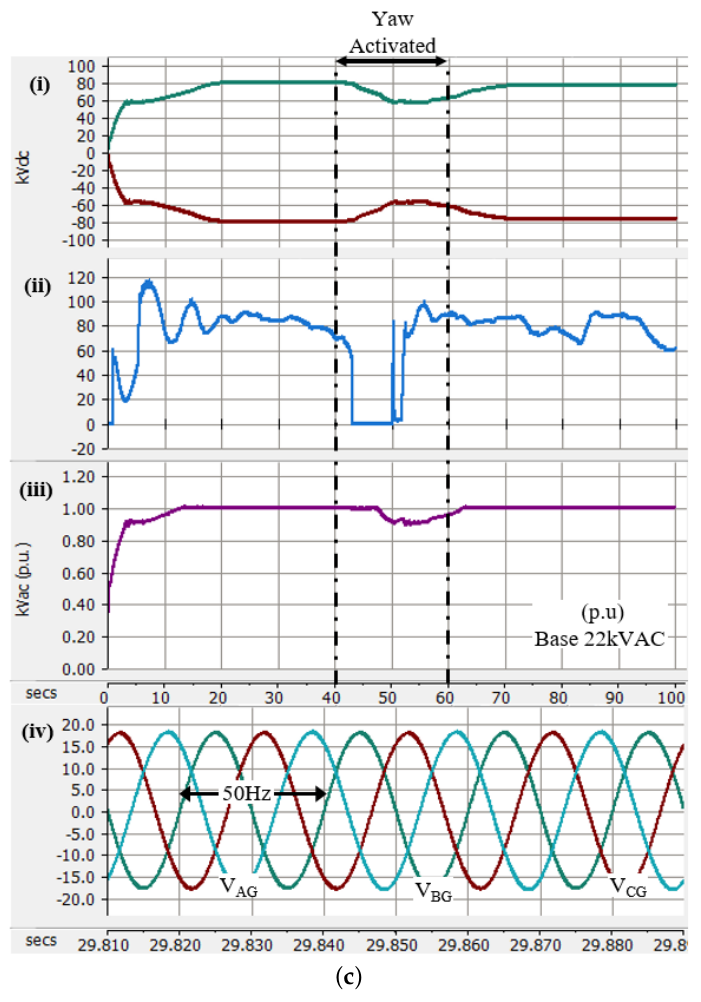
Figure 10. ( a ) tidal current profiles ( knots ) for three separate channels across six TSTs; ( b ) DCCA’s AC-Link Busbar coupling six TSTs; (i) power (MW) and voltage profiles; (ii) voltage transient detecting two dipping events during TST start-ups; ( c ) transient responses at PCC Busbar and bi-pole HVDC transmission; (i) bi-pole HVDC-Link voltage (sending-end), kVDC ; (ii) harvested active power yield from TST farm at PCC, MW; (iii) voltage transient at PCC busbar; (iv) instantaneous voltage transient at PCC